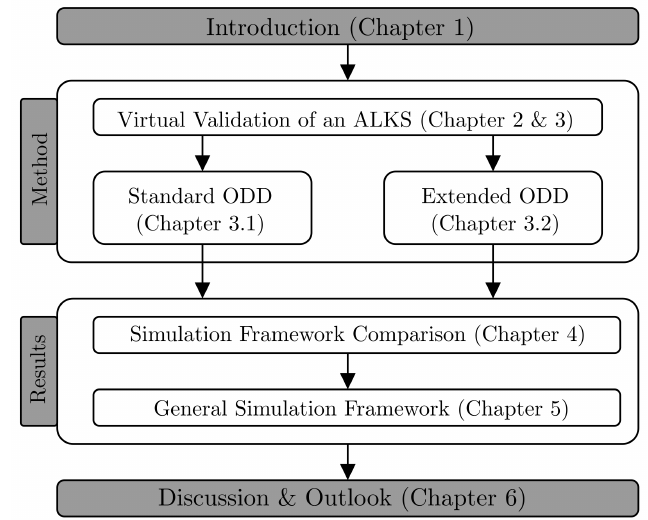
Figure 2. Graphical representation of the different chapters in this article.